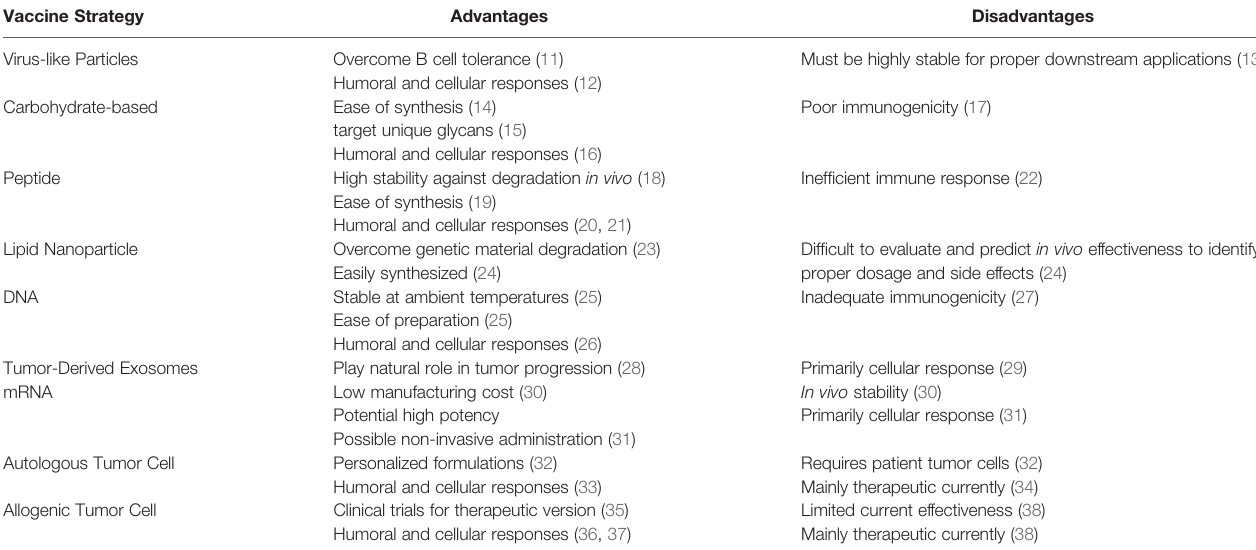
TABLE 1 | Advantages and disadvantages of different prophylactic cancer vaccine strategies currently being investigated. Vaccine